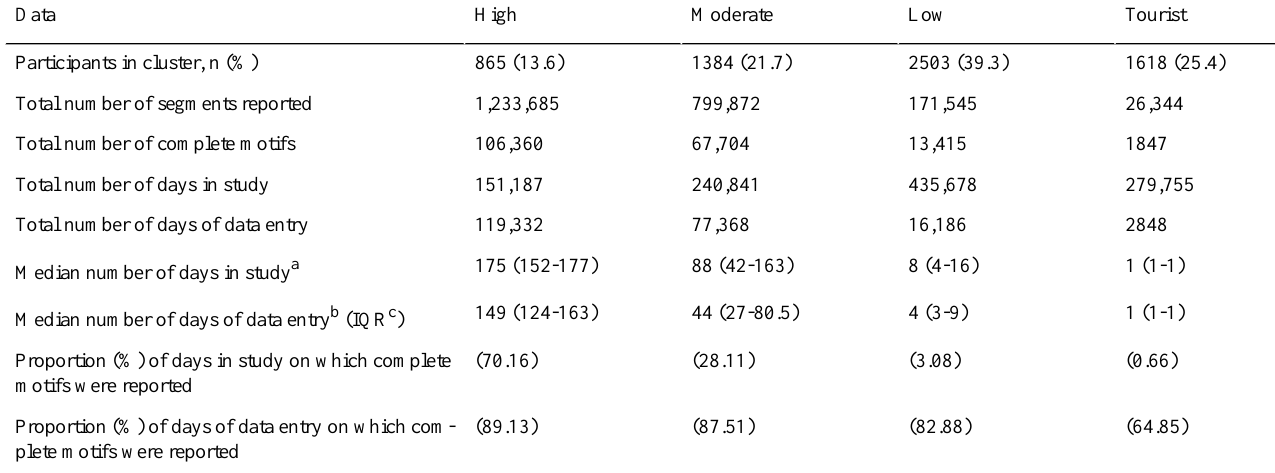
Table 3. Data provided by 6370 Cloudy with a Chance of Pain participants clustered by levels of engagement.